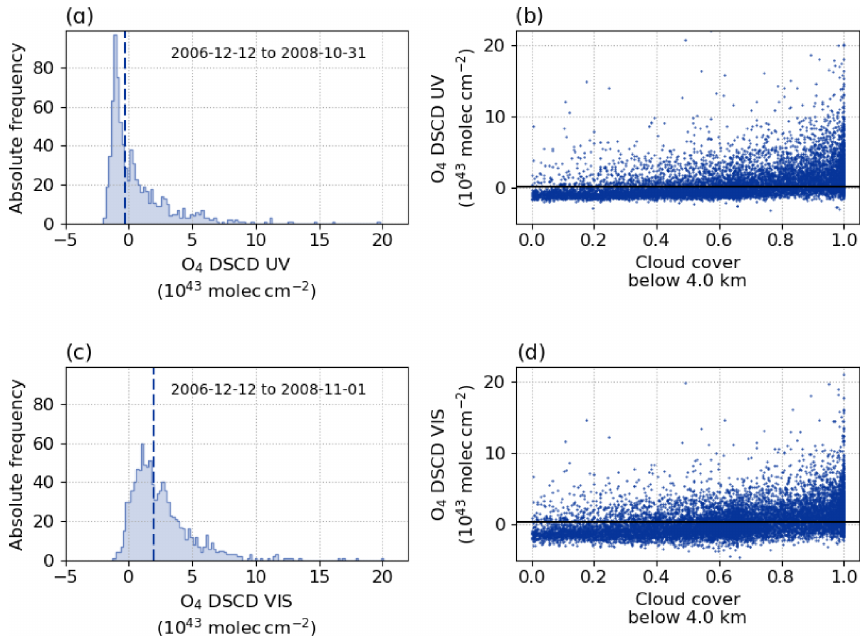
Figure A1. (a, c) Distribution of the O 4 DSCDs in the UV (upper) and visible (lower panel) spectral range for an analysis period in 2007. The median is indicated by a vertical line. (b, d) O 4 DSCDs in the UV (upper) and visible (lower panel) spectral range (1999–2018) are correlated to ECMWF cloud fraction data. The ECMWF data are averaged in the vicinity of the Neumayer station and the cloud cover below 4km altitude is considered. The filter threshold (black line) is defined as the 75th percentile of the O 4 DSCDs, considering only data points where the ECMWF cloud fraction is < 0 .